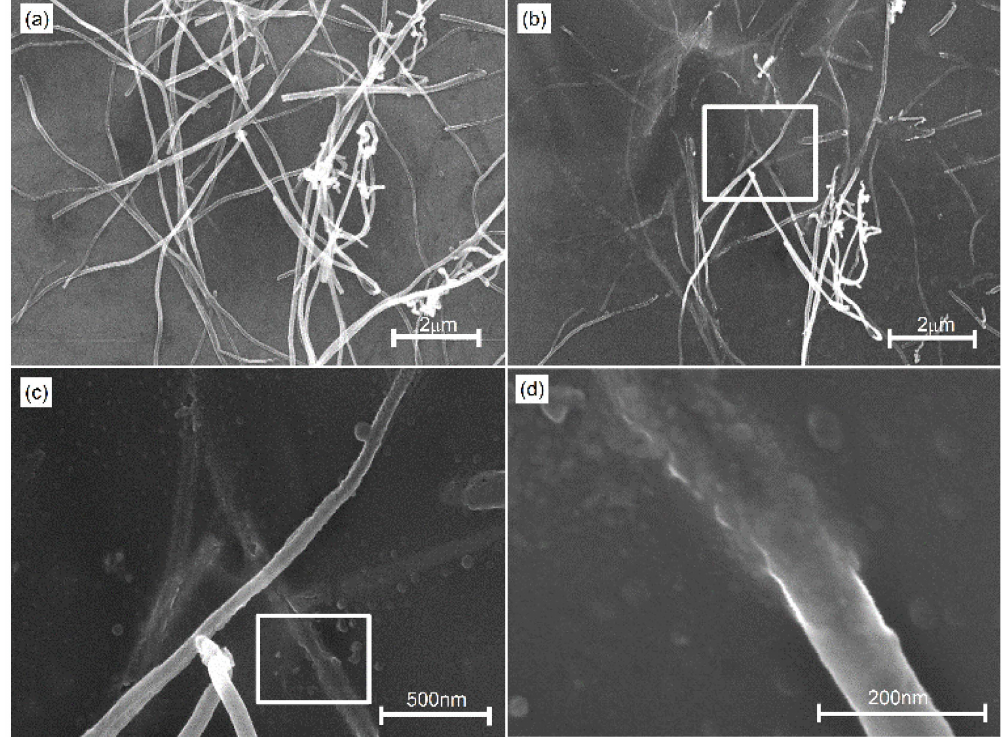
Figure 4. SEM images of MWCNTs samples: ( a ) raw MWCNTs on silicon surface; ( b ) MWCNTs after 12.5 s laser irradiation; ( c ) the magnified SEM image of white rectangle in Figure 4b; and ( d ) the magnified SEM image of white rectangle in Figure